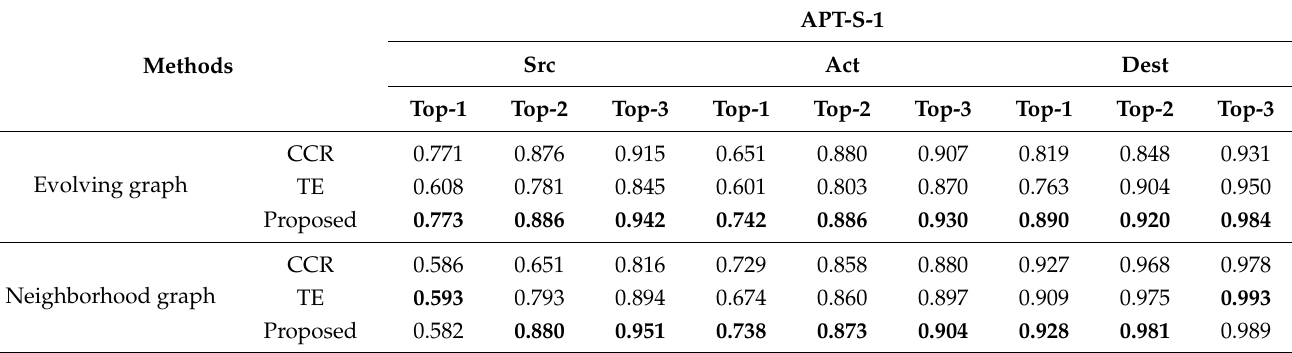
Table 7. Performance based on APT-S-1.